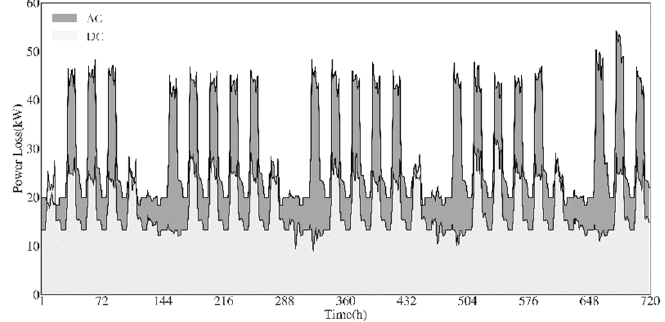
Figure 6. Hourly power loss profiles for AC and DC in a month.